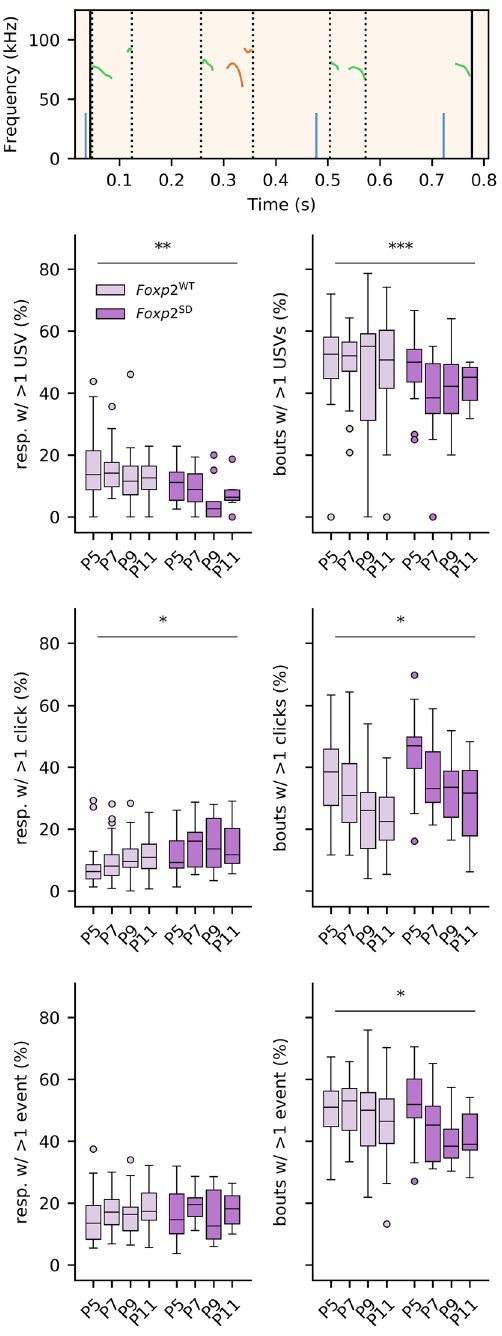
Figure 5. Call patterning within respirations and within bouts are affected in Foxp2- SD mice compared to WTs. Top: An illustration of vocalizations occurring within the same respiration (dotted vertical lines). These sets of USVs are considered to be a single unit when considering the bout sequencing of calls. The solid black lines indicate a single bout made up of three USV-containing respirations. Left column: the percentage of respirations with more than a single USV (top), the percentage of respirations with more than a single click (middle), and the percentage of respirations with more than a single event. The number of USVs within a respiration is reduced in the Foxp2- SD mice. The number of total events within a respiration is unaffected. Considering the sequencing of these respirations within bouts, we found that a lower percentage of bouts emitted by the Foxp2- SD mouse pups contain more than one USV-containing respiration, indicating an inability to produce longer sequences of USVs. In contrast to this, the percentage of bouts made up of more than one click-containing respirations is increased in the Foxp2- SD mutants. Lastly, we found a reduction in the overall percentage of bouts longer than one respiration in the Foxp2-SD mice. This reduction could be the result of USVs being more likely to be patterned into bouts, which is evident from the higher percentage of bouts with more than one USV-containing respirations. Significance: * p < 0.05; ** p < 0.01; *** p < 0.001. The Y-axis scaling is the same for each